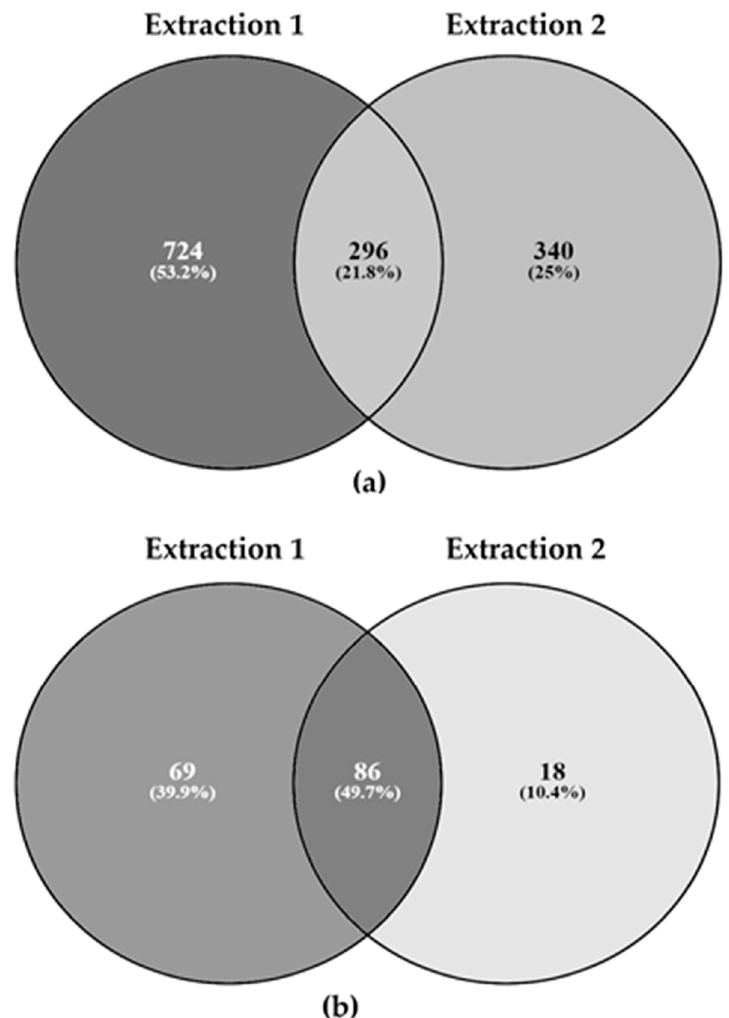
Figure 2. Venn diagrams comparing the numbers of peptides (a) and proteins (b) detected in 18 IM samples using a bottom-up proteomics. Extraction 1 and 2 refer to the two different extraction methods applied in Laboratory A and B. The intersection of the two circles shows the number of commonly detected peptides (a) and proteins (b). Table 5. Total numbers of spectra and successfully identified insect specific proteins and peptides in 18 insect meal samples, performed independently at two different laboratories (A and B).